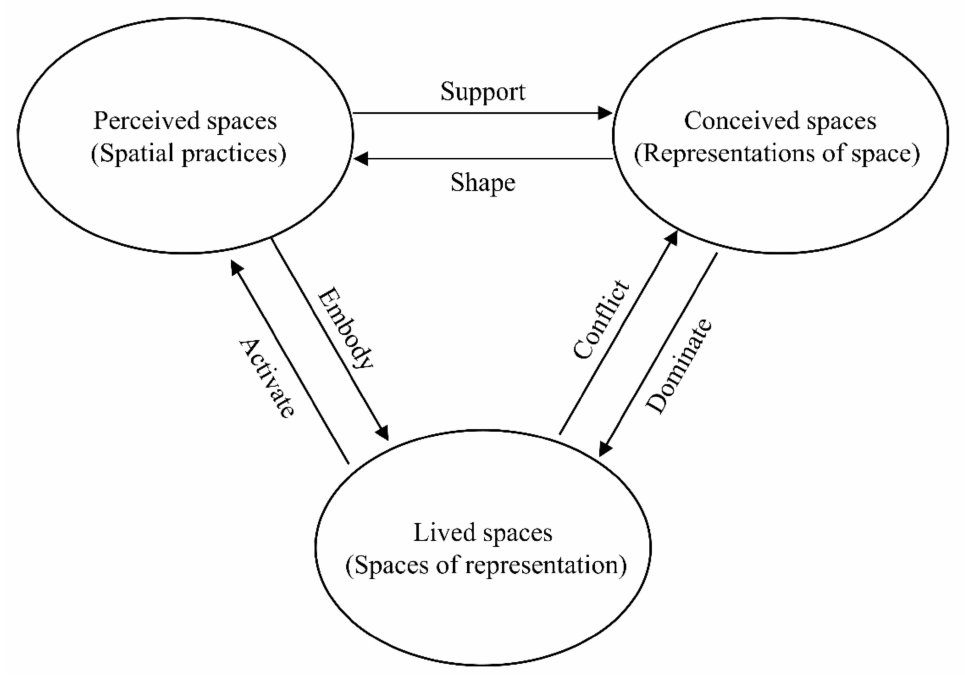
Figure 1. Analysis framework for production of space (source: the